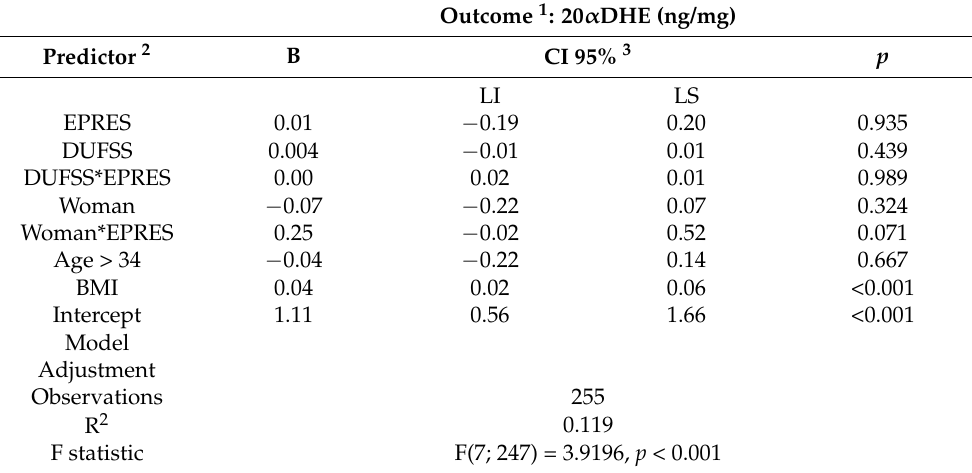
Table A1. Regression results of social support and employment precariousness interaction model predicting 20 α DHE